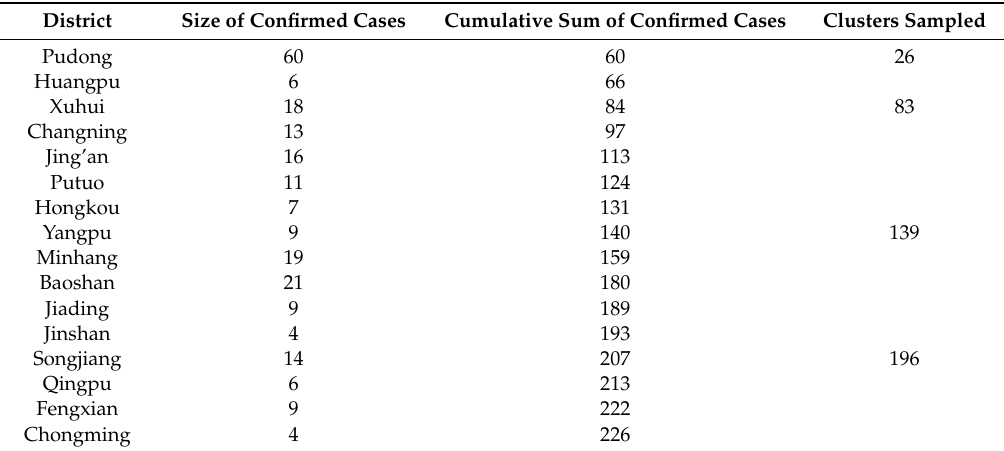
Table 1. Probability proportional to size (PPS) sampling of primary sampling units (PSUs) for close contacts.